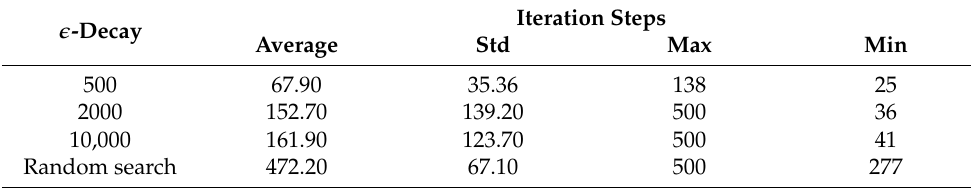
Table 4. Comparison of iteration steps to convergence for varying epsilon decay and random search.